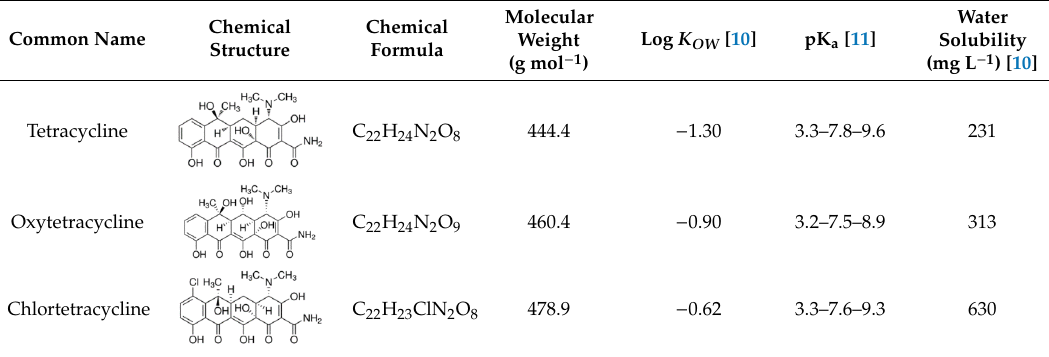
Table 2. Main characteristics of three different tetracycline antibiotics.